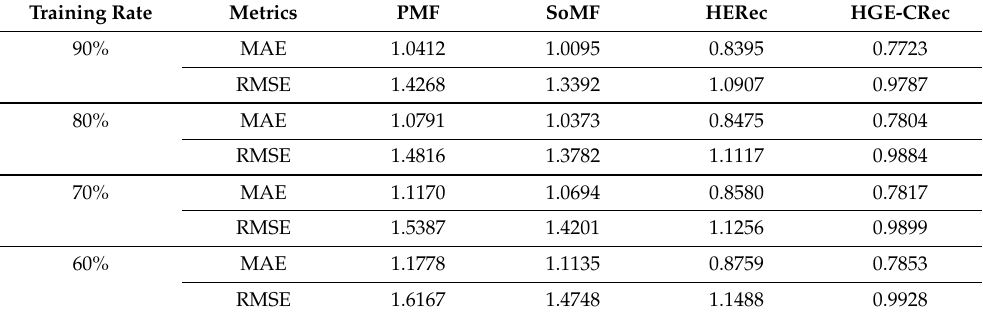
Table 6. Results on Yelp.